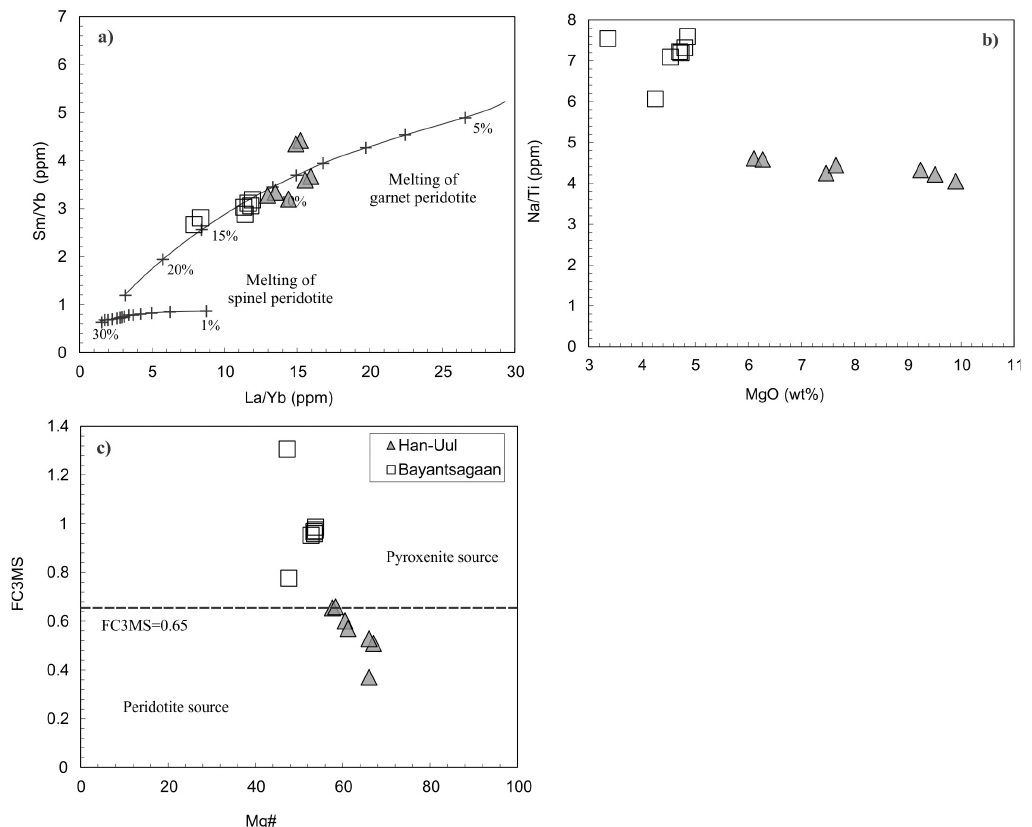
Fig. 9. Diagram of La/Yb versus Sm/Yb (a) Na/Ti cation fraction ratios with MgO (b) FC3MS versus Mg# (c) for all analysed basaltic samples from Bayantsagaan and Han-Uul. Batch melting curves calculated for garnet peridodite. Partition coefficients are taken from Putirka